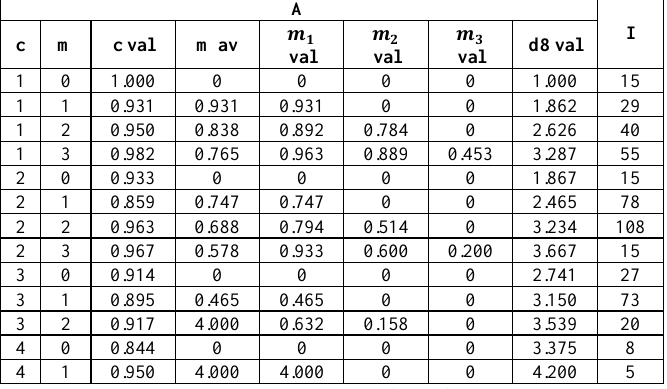
Table 2: Average of the Survival Rate for XY-brood type during the Good Years.